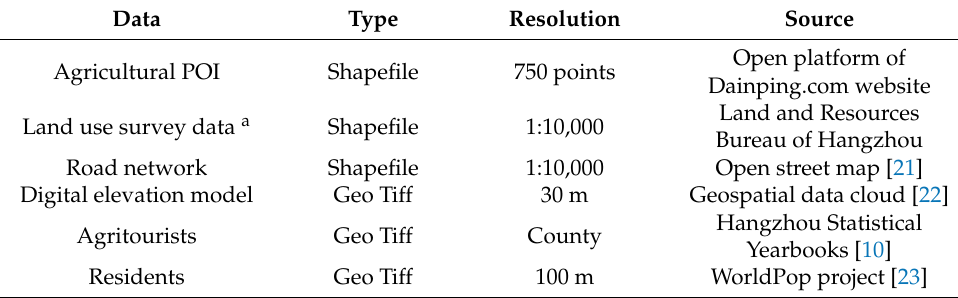
Table 1. Description of the datasets utilized in this